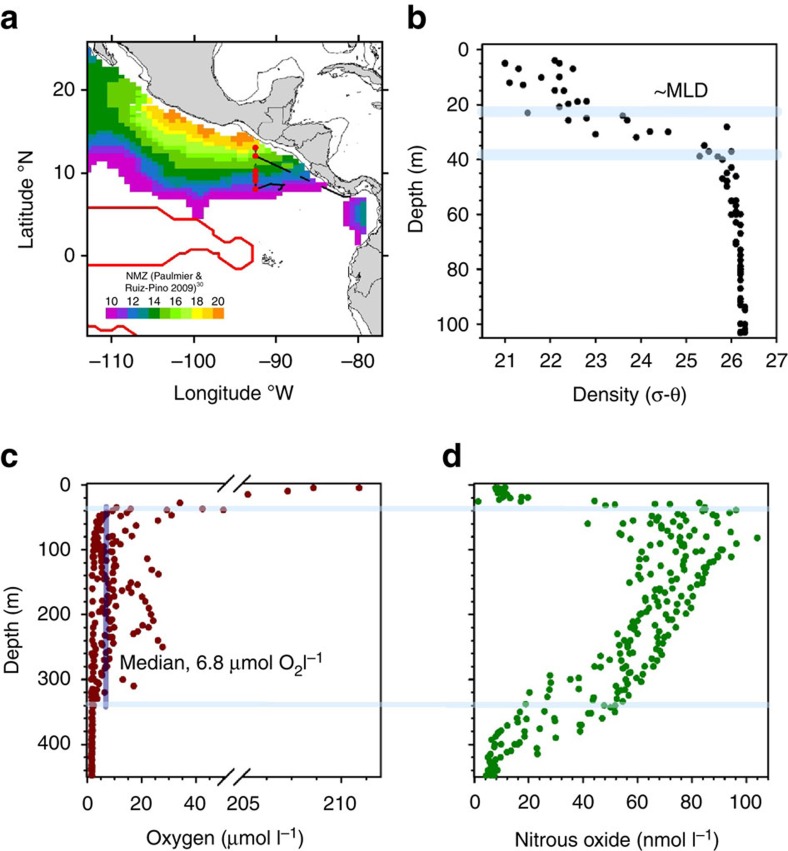
Open ocean OMZ sites and main water column profiles.(a) Offshore transect (bold black line with sites as filled red circles) through the nitrite maximum zone (NMZ) from 13 °N, at approximately 120 km off the coast, to 8 °N, at 670 km offshore. The red line marks the boundary of the permanent OMZ (min. O2<20 μmol l−1,) and the colour indicates the intensity of the nitrate deficit (>10 μmol l−1) within the NMZ (reprinted from ref. 80). (b) Density as a function of depth: upper light-blue line, approximate mixed layer depth (MLD); and lower light-blue line, base of the pycnocline. (c) Oxygen dropped rapidly in the pycnocline to ≤50 μmol O2 l−1 at its base (upper light-blue line) but remained above the limit of detection for the Seabird Sensor (∼ 1.6 μmol l−1) to 340 m (lower light-blue line). Within these boundaries (light-blue lines in c,d), oxygen was present at 6.8 μmol l−1, on average (median, vertical dark-blue), and we measured a broad peak in N2O (d). Profiles to 700 m are given in Supplementary Fig. 1. Panels b–d were drawn in SigmaPlot (Systat Software, San Jose, CA, USA).